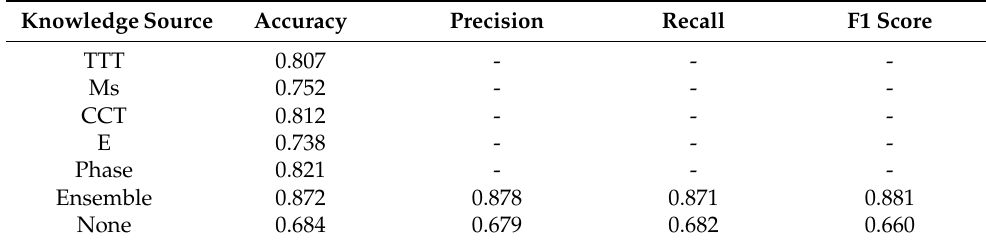
Table 5. The scores of transfer learning on high-entropy alloys